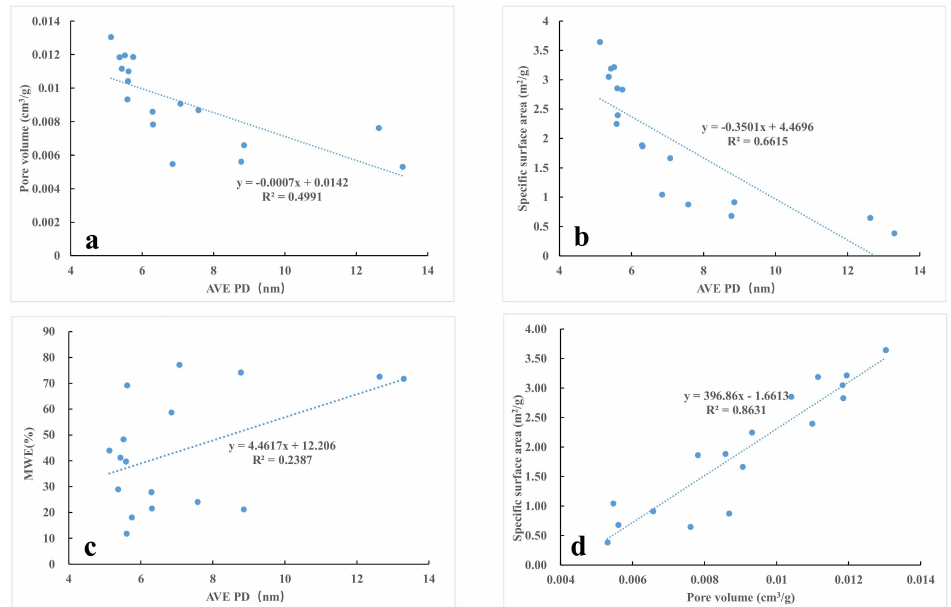
Figure 10. Relationship between different pore structure parameters: ( a ) relationship between PV and AVE PD; ( b ) relationship between SSA and AVE PD; ( c ) relationship between MWE and AVE PD; ( d ) relationship between PV and